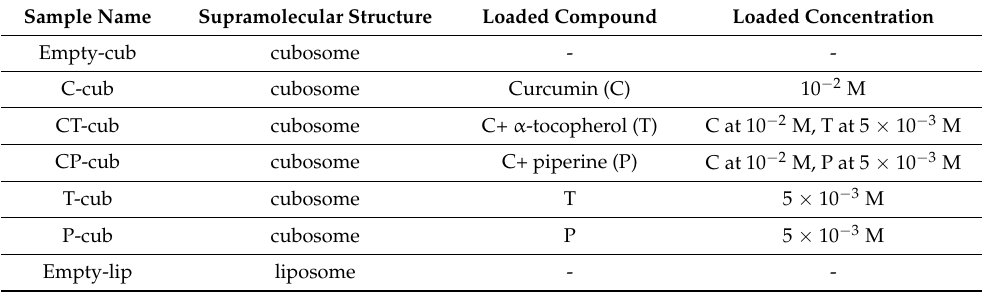
Table 1. Sample names, structure [34] and loaded compound for the systems used in this study. Samples loaded with only tocopherol or piperine were employed for antioxidant capacity assay and cell tests for comparison, in order to evaluate the antioxidant effect of these molecules alone and then their synergic action with